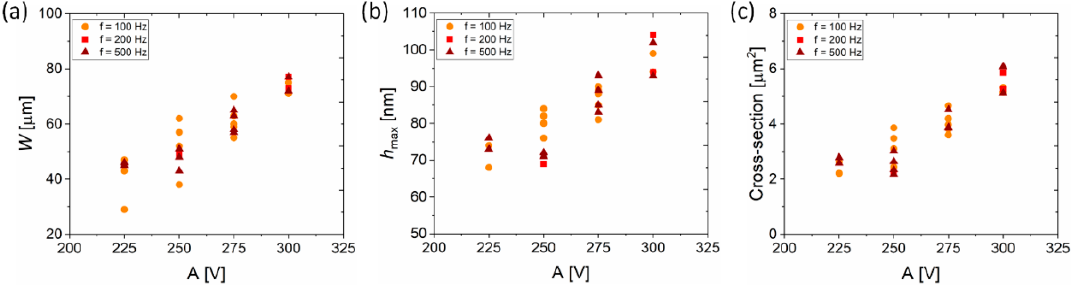
Figure 6. Summary of the geometrical features of the overprints fabricated with different A and f . ( a ) Width, ( b ) maximum height and ( c ) cross-section of the overprints increases for the higher voltage amplitude.